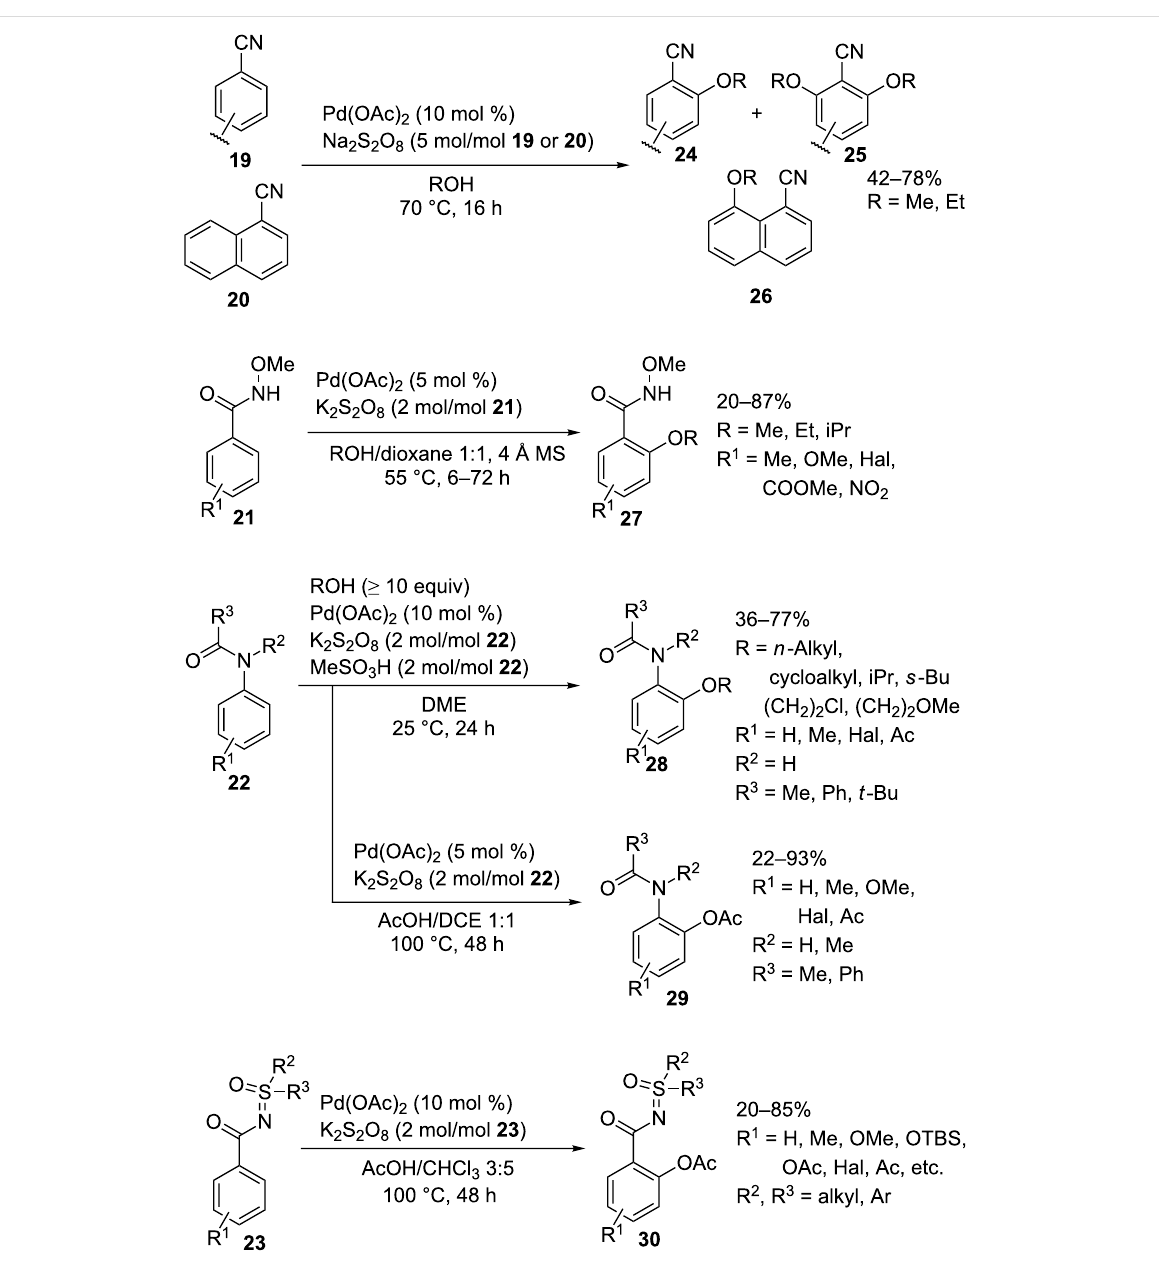
compared with the alkoxylation of structures 46 – 49 [64]. Under similar conditions, aryl phosphates and benzyl phosphonic monoacids were subjected to ortho -acetoxylation in the pres- ence of the Pd(OAc) 2 /PhI(OAc) 2 system; (diacetoxy- iodo)benzene served as the source of the acetoxy group [65]. The quinoline-8-amine directing moiety was used for copper- catalyzed aerobic ortho -aryloxylation and alkoxylation of arenes 59 with electron donating or electron withdrawing